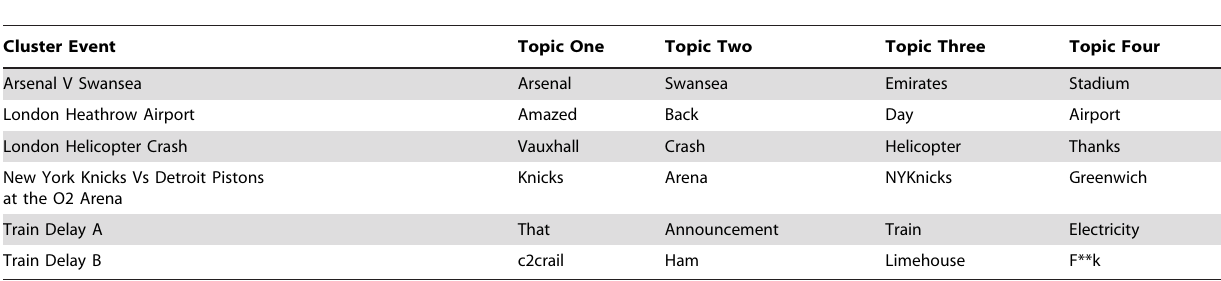
Table 4. Significant clusters identified during hourly aggregations using Latent Dirichlet Allocation and their associated topics.